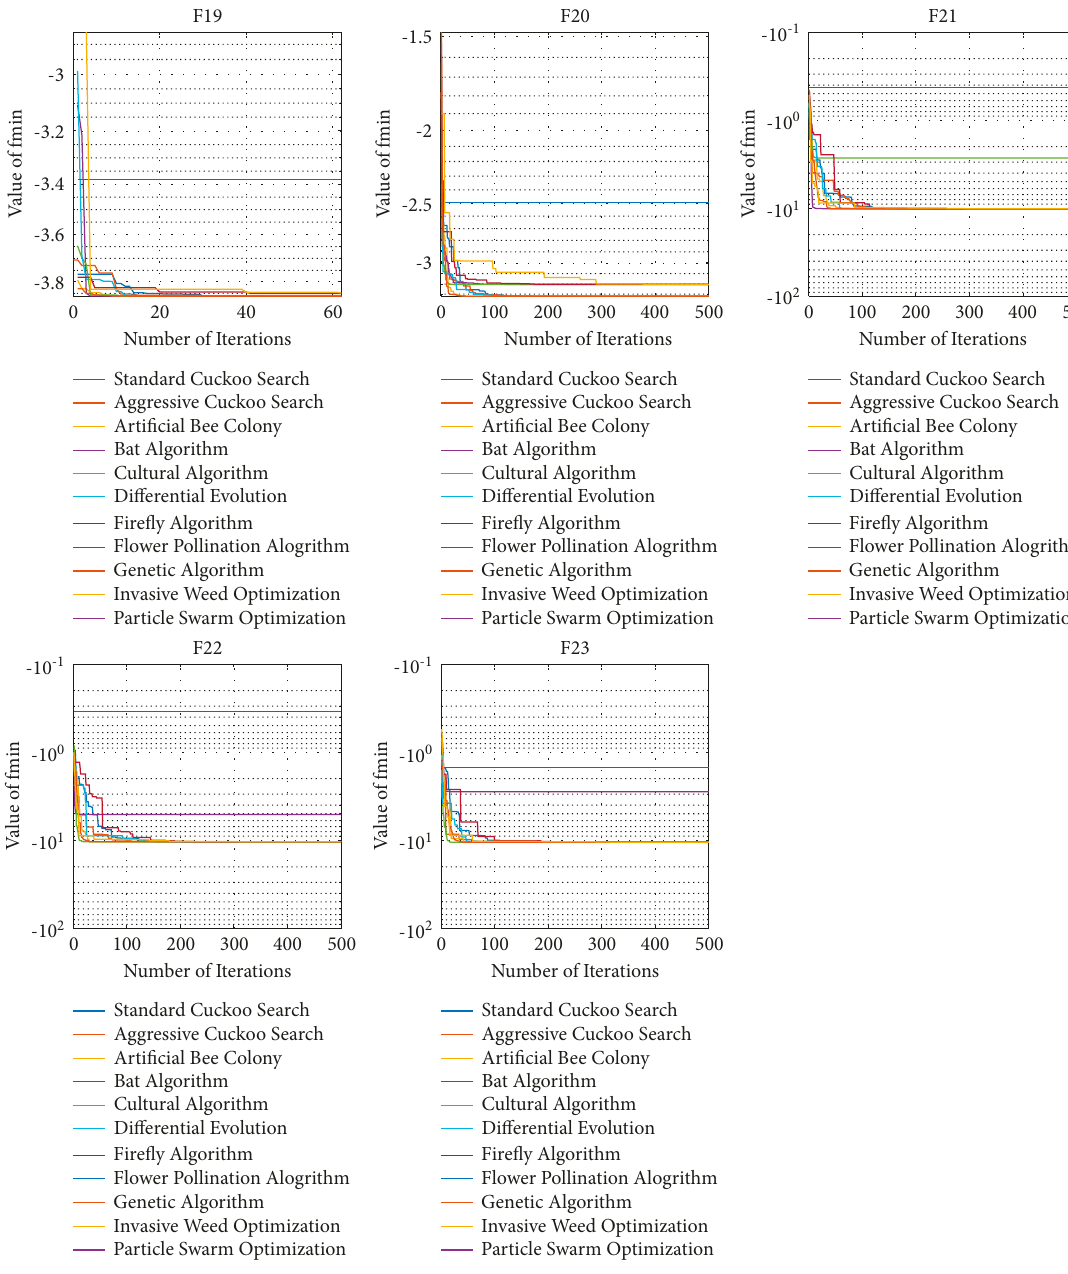
Figure 5: Comparison of the convergence curves of ACSA with the other optimization algorithms for all benchmark optimization